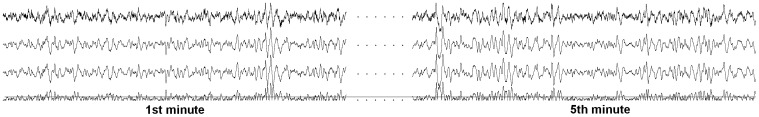
Computation of slow-wave amplitude, SWA.First and last minute of a typical five-minute period of N3 sleep. Traces from top to bottom show the C4-M1 EEG unfiltered (trace 1) and after bandpass filtering (trace 2) and additional Notch-filtering (trace 3) and finally also rectification (trace 4). The dotted lines indicate the 0 µV level and the vertical distance between those lines is 200 µV. The solid horizontal line in trace 4 shows its 5-minute average, SWA, which in this case was 24 µV.